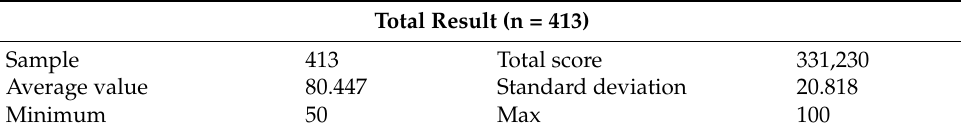
Table 7. Systematic learnability